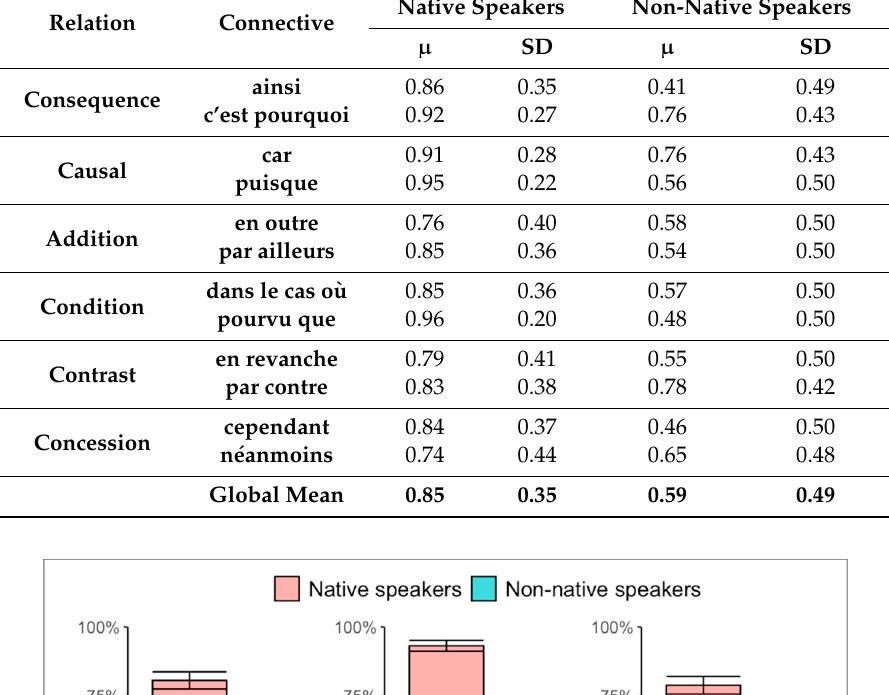
Table 3. Mean scores per connective by native and non-native speakers.